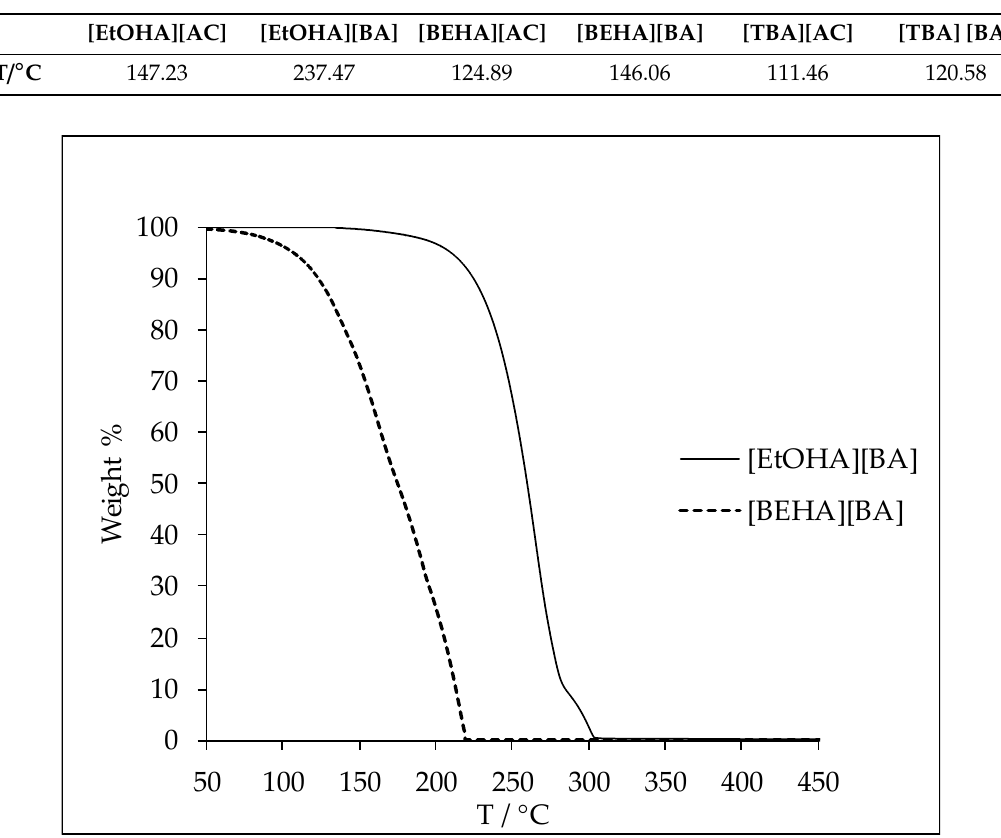
) temperature of the ionic liquids. d